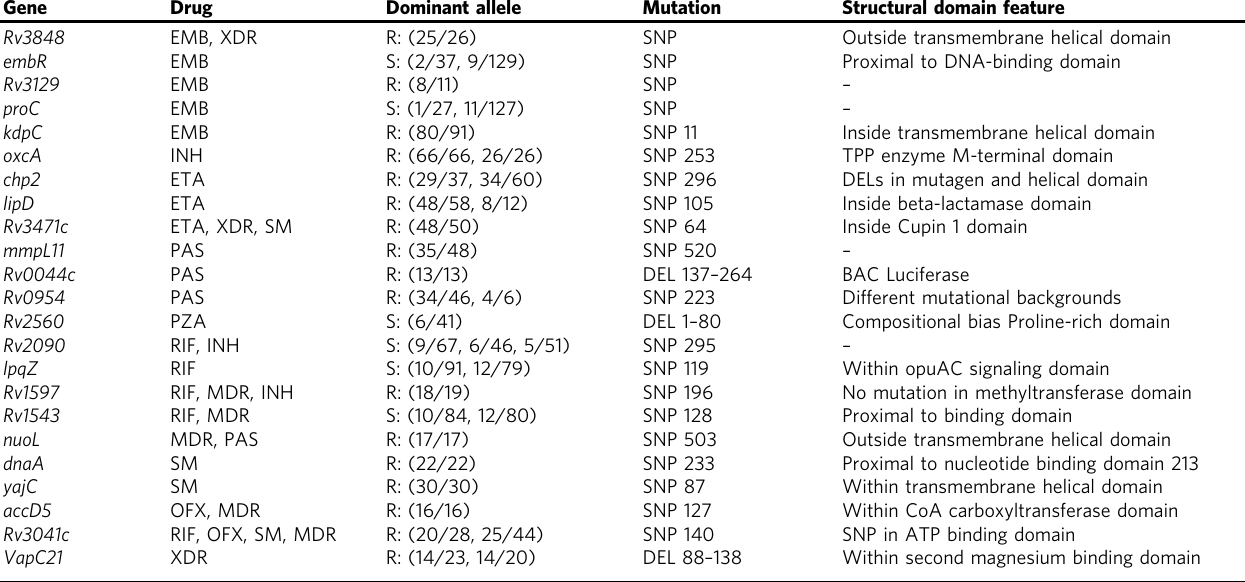
Table 2 Newly proposed AMR